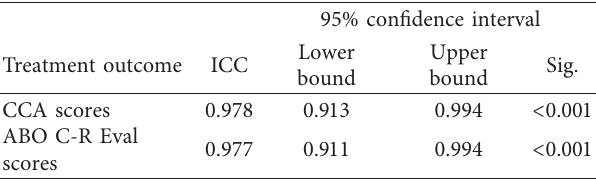
Table 1: Intraexaminer reliability. Table 2: Sample characteristics ( N � 287).